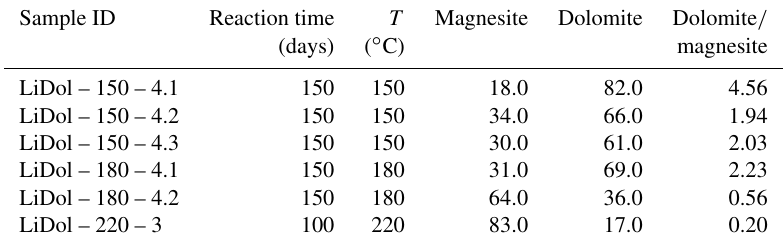
Table 1. Reaction temperatures and mineral content from the precipitation experiments. Sample